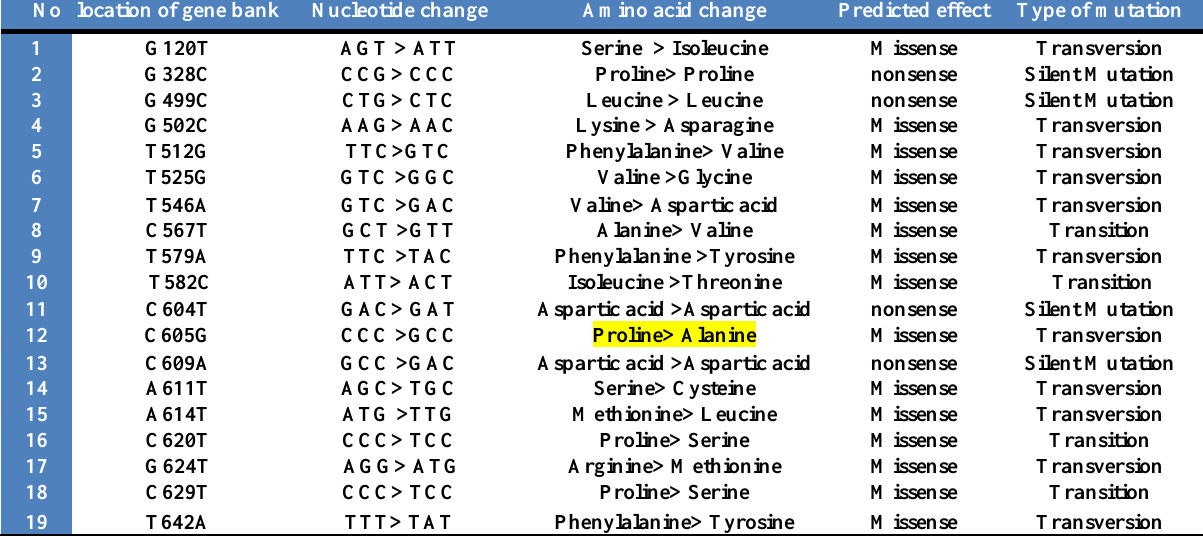
Table, 1: location, type of polymorphism, mutations and amino acid change in sense of melatonin receptor type 1A MTNR1A gene in Iraqi